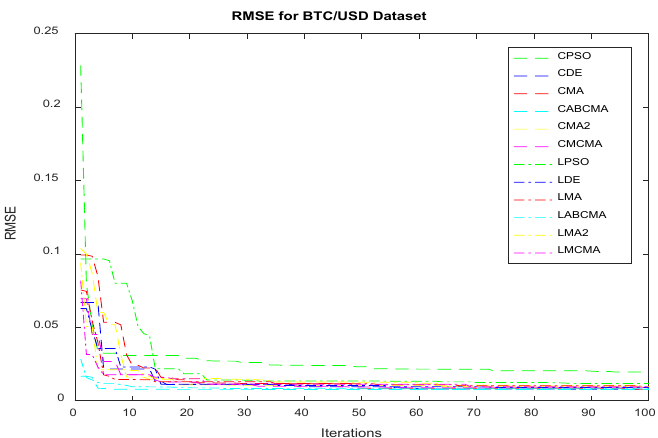
Figure 9. RMSE plot for BTC/USD dataset.